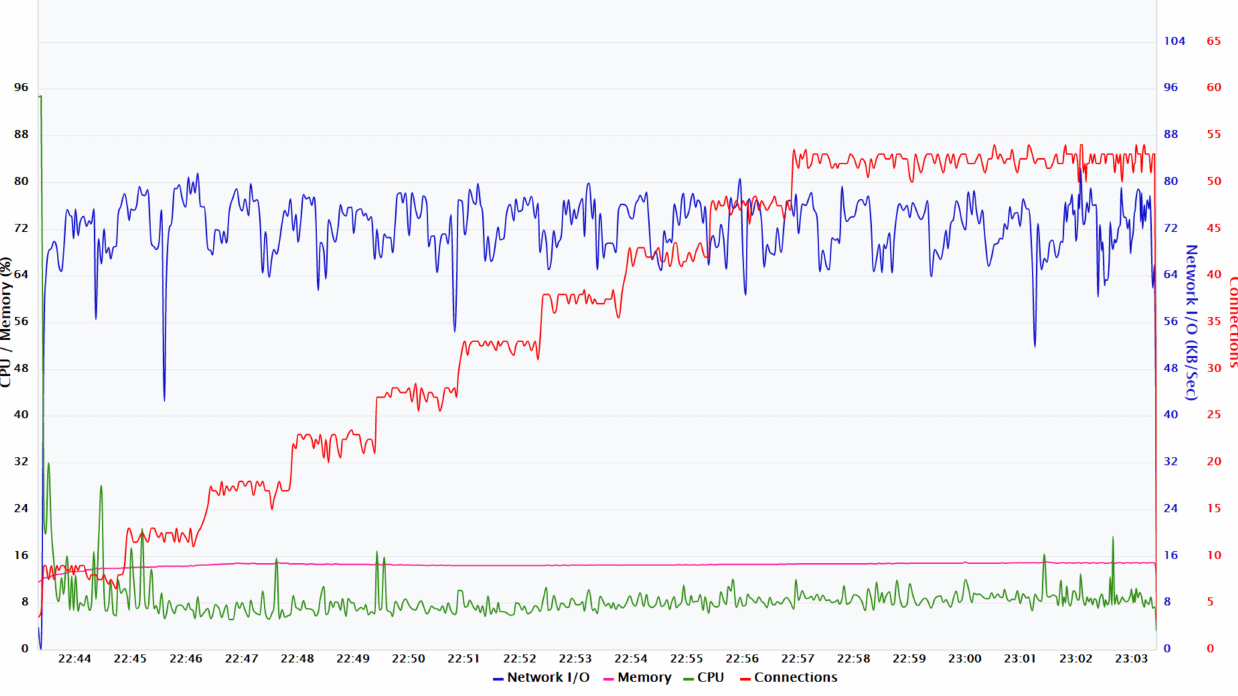
Figure 5. Engine Health Report SPIDEP-MSA-K8s-T1. The colored lines represent various parameters as follows: the blue line is the bandwidth traffic; the purple line is the memory load generated by the users; the green line is the CPU load generated by the users; and the red line is the active connections within the